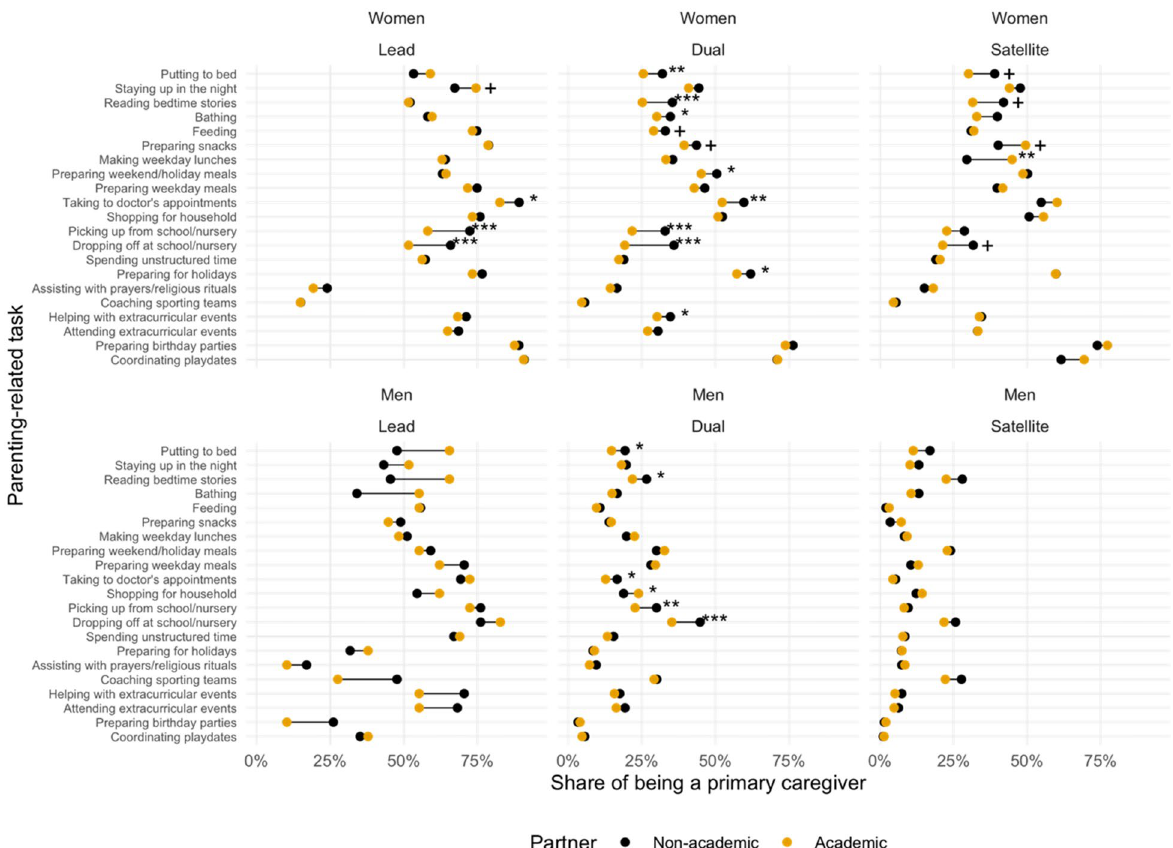
Figure 2. Respondents with an academic employment (n = 8,046) reporting being a primary caregiver for the parenting-related activities by parenting type, gender, and partner employment status (Academic vs.